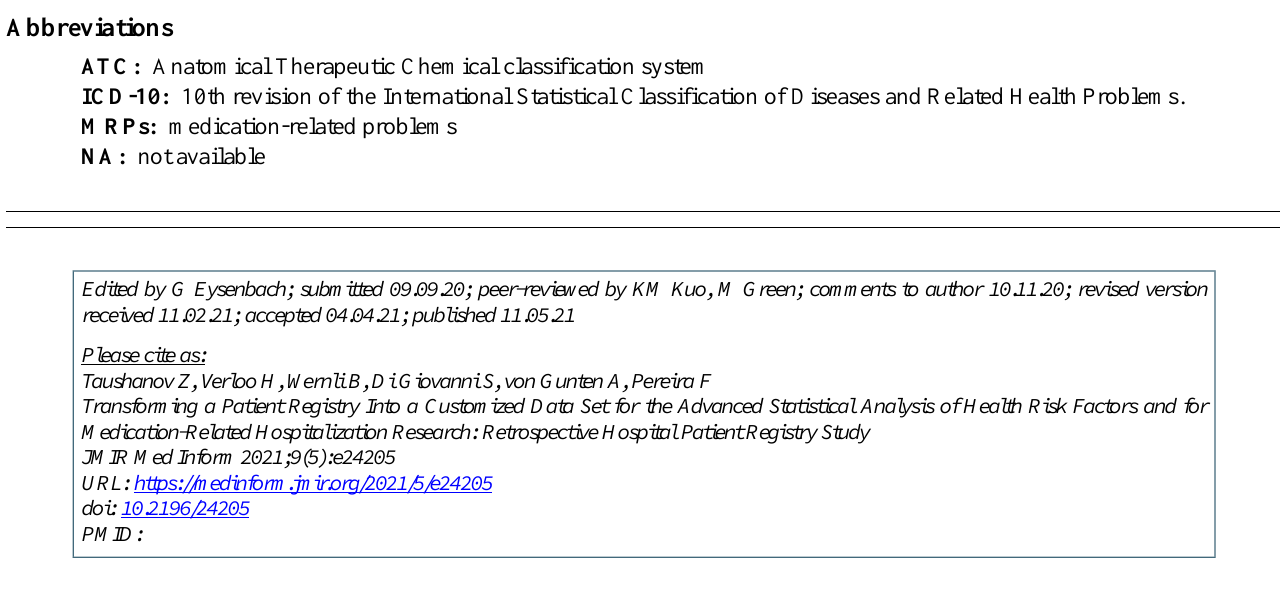
for polymedicated home-dwelling older adults with multiple chronic conditions: a mixed-methods study protocol. BMJ Open 2019 Oct 28;9(10):e030030 [FREE Full text] [doi: 10.1136/bmjopen-2019-030030] [Medline: 31662367]